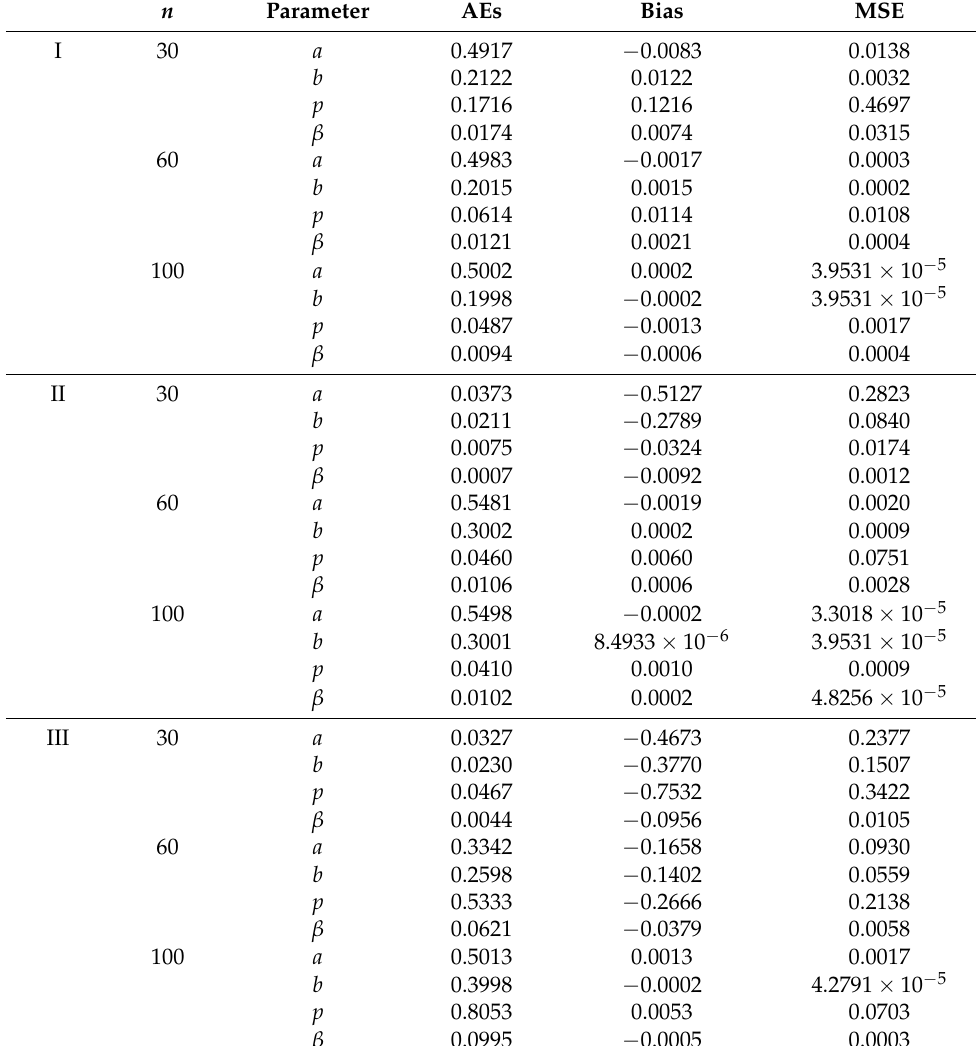
Table 2. AEs, Bias, and MSE of parameters based on 1000 simulations of the OELW